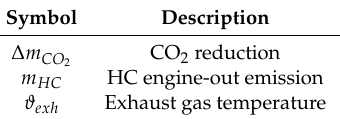
Table 5. Output variables.